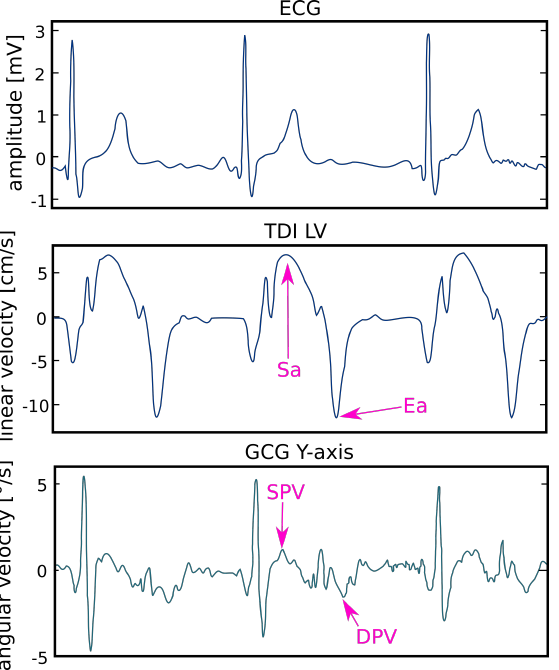
Figure 7. The comparison of ECG, LV TDI and GCG y-axis with marked Sa, SPV, Ea and DPV. An excerpt of a diagram in the article by Tadi et al. [11] under the CC-BY 4.0